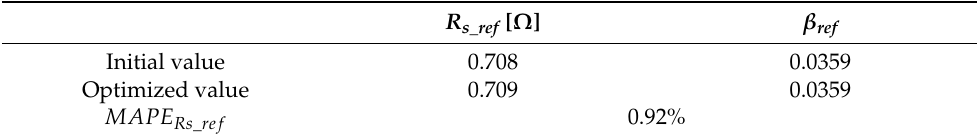
Table 8. Extracted reference values for constant G poa . Figure 16. Evolution of 𝑅 (cid:3046) for constant 𝐺 (cid:3043)(cid:3042)(cid:3028) . Table 8 . Extracted reference values for constant 𝐺 (cid:3043)(cid:3042)(cid:3028) .